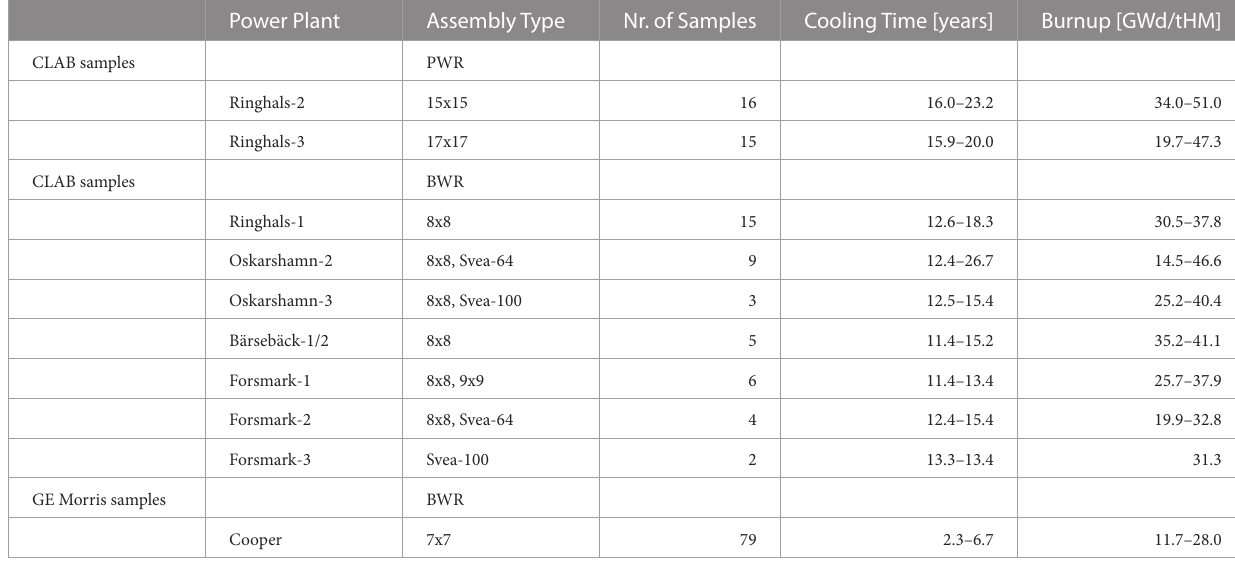
TABLE1 Summaryofdecayheatmeasurementsamplesusedforthevalidation.